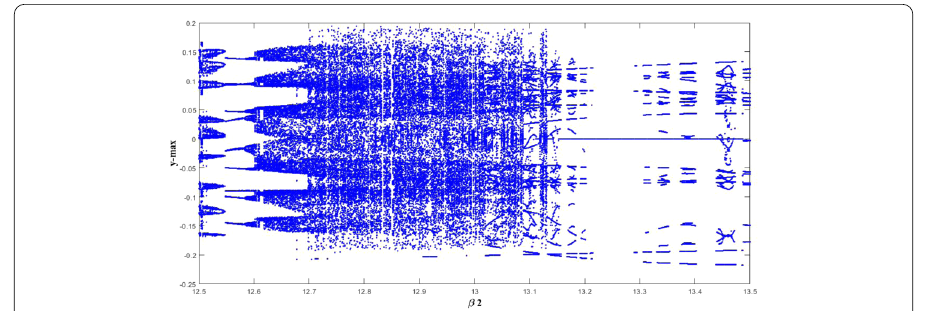
Figure 6 Bifurcation diagram for variation of β 2 in (12.5,13.5)